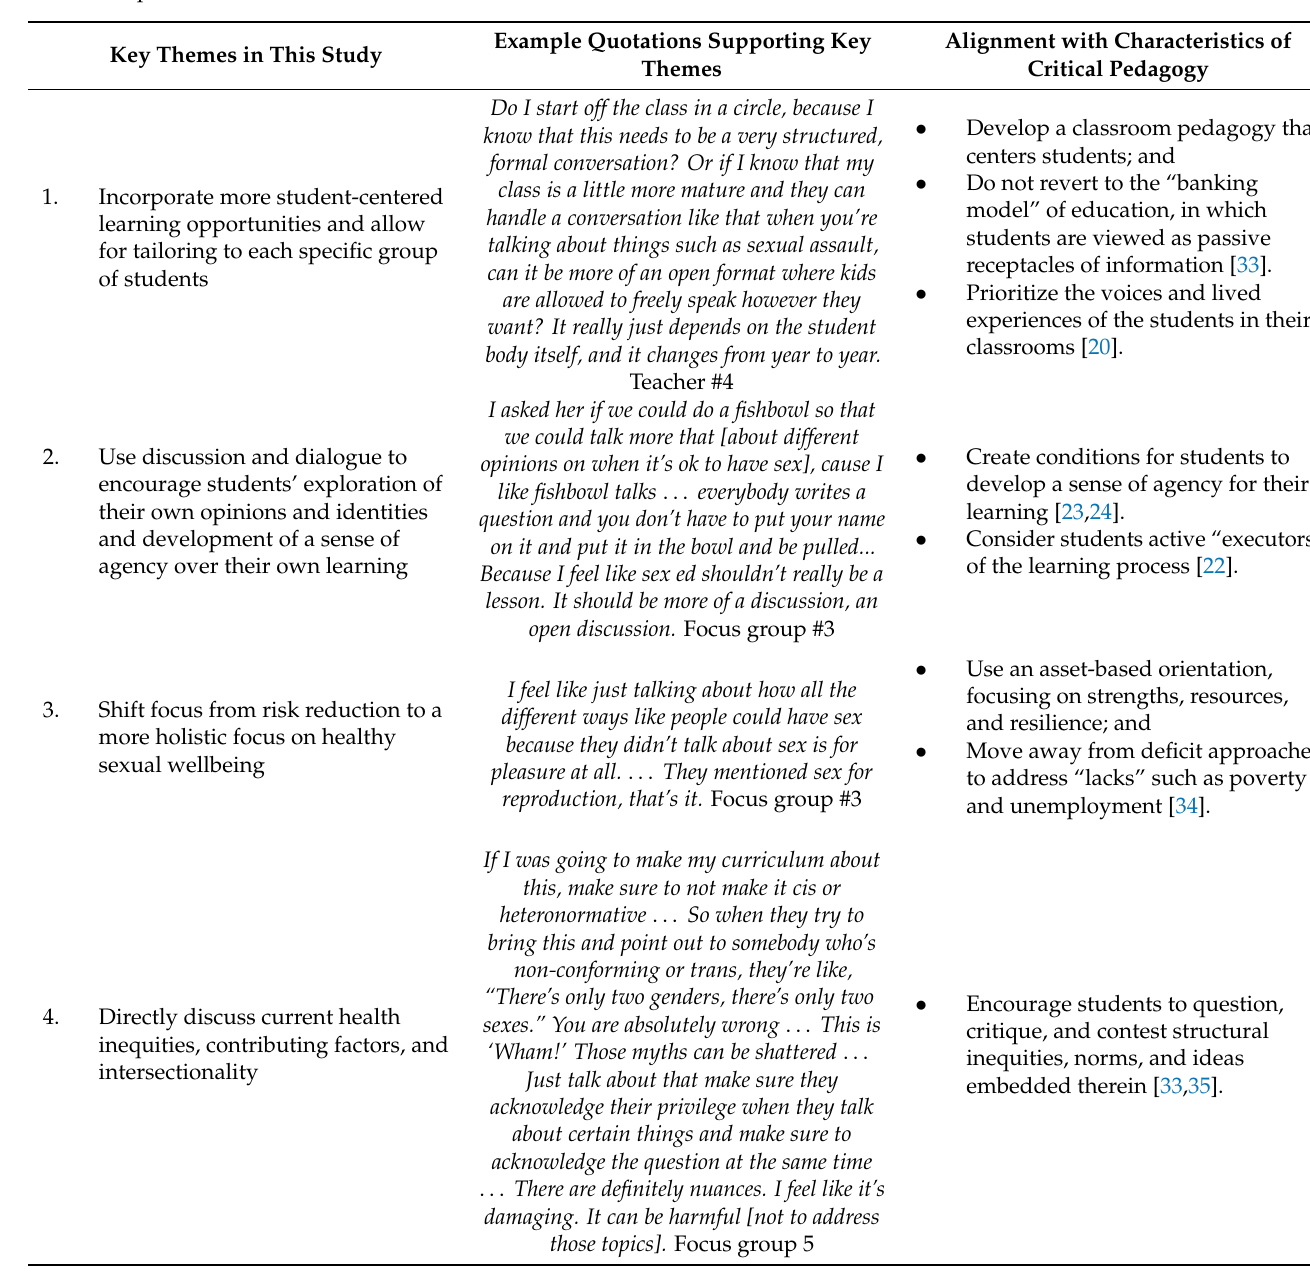
Table 3. Key themes from this study, example quotations supporting key themes, and alignment with critical pedagogy